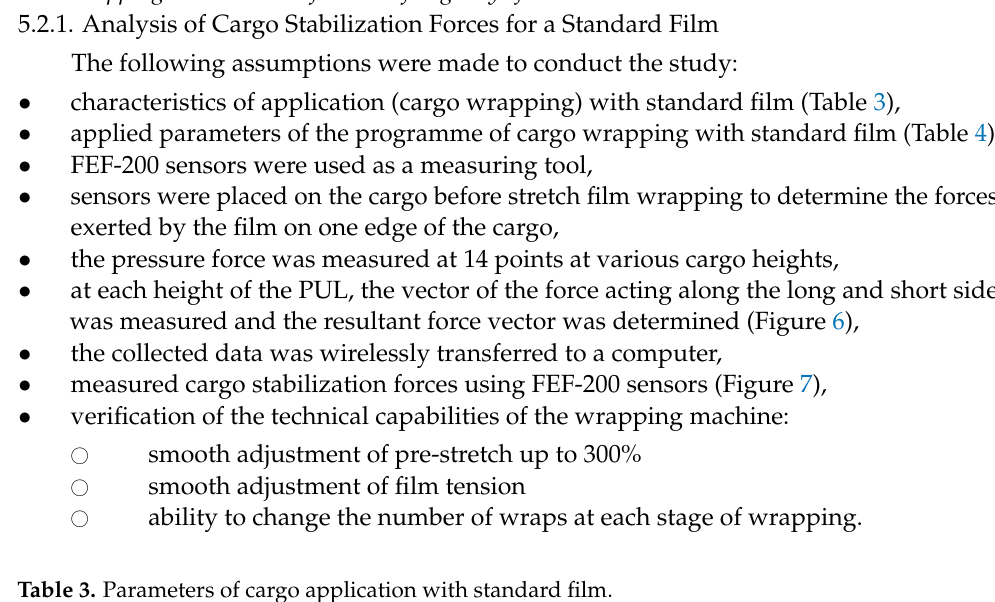
Table 3. Parameters of cargo application with standard film.